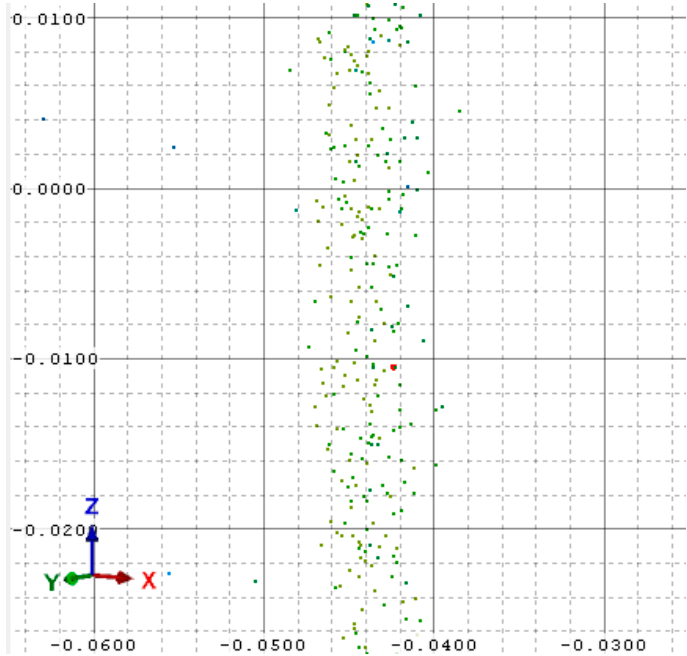
Figure 7. The noise level evaluation on the example of a wall of a building in meters. Figure 7 points it out that the deviation from various scan positions does not exceed 8 mm.